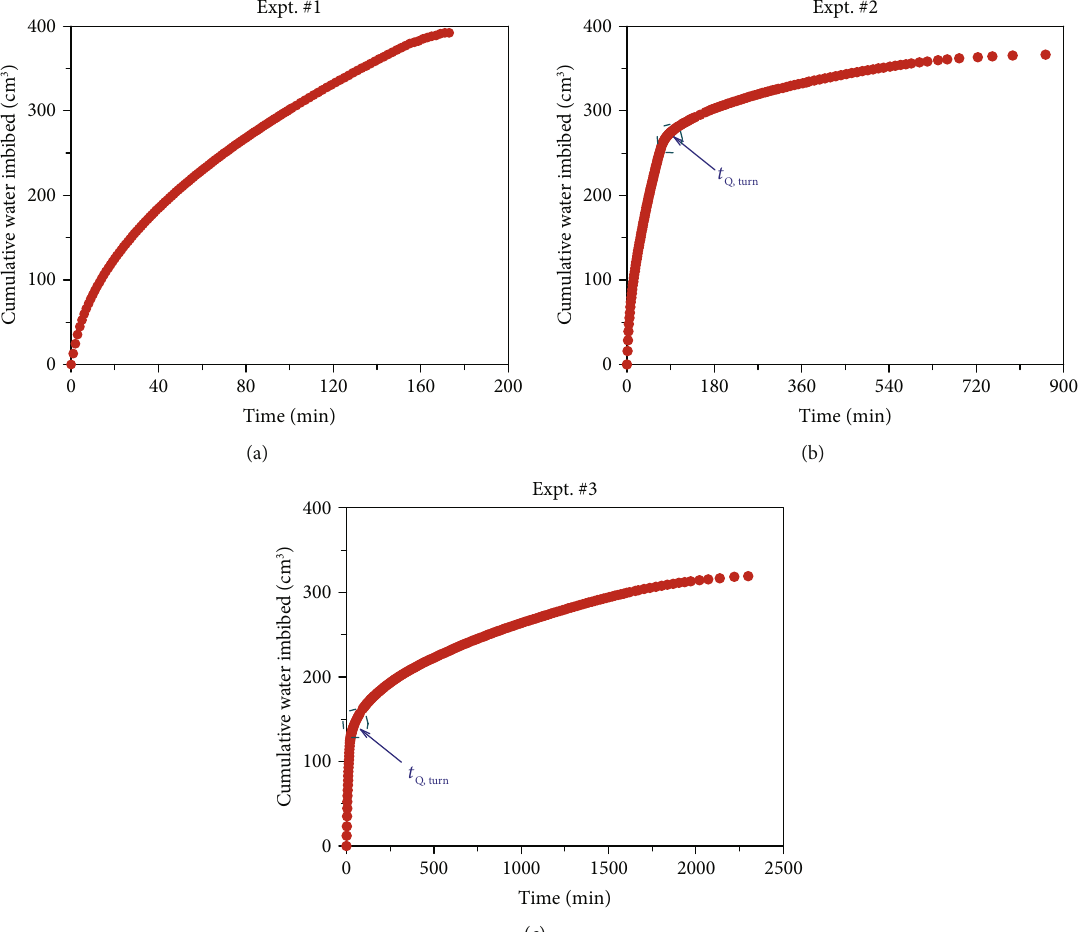
Figure 5: The cumulative water imbibed as a function of time for experiments 1-3.